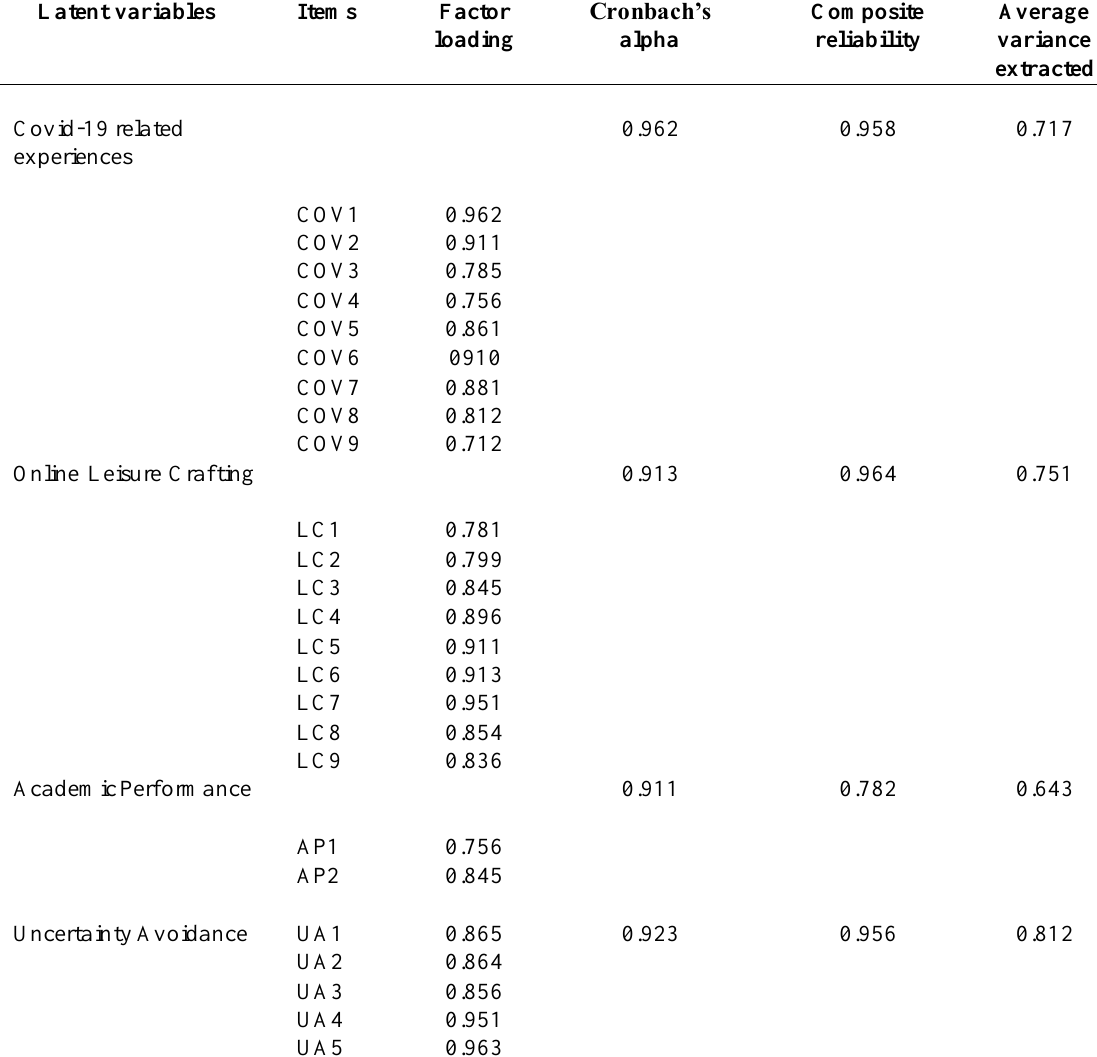
Table.2. Reliability Analysis